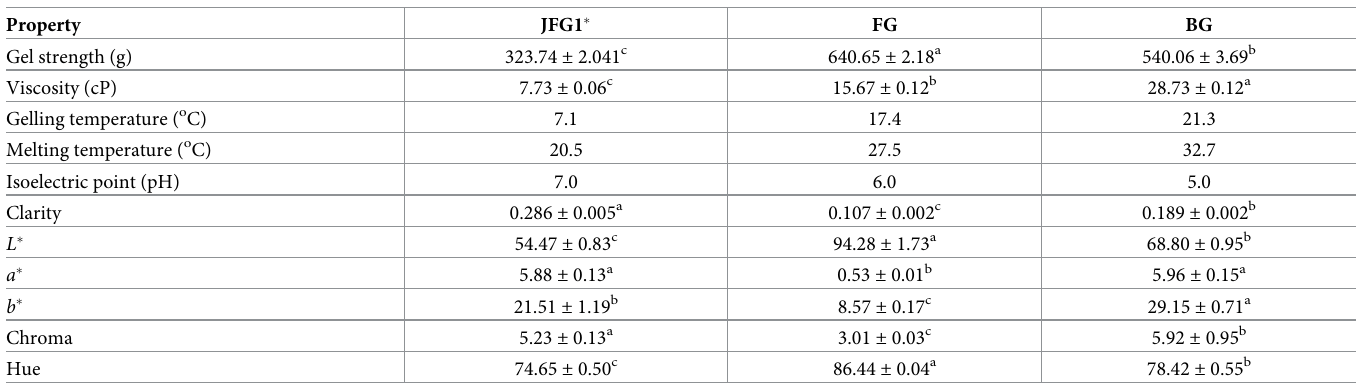
Hue JFG1 � was from the extraction of 0.1 M HCl, 60˚C for 12 h Values are mean ± SD from triplicate determinations. Means with different letters in the same row are significantly different (p <